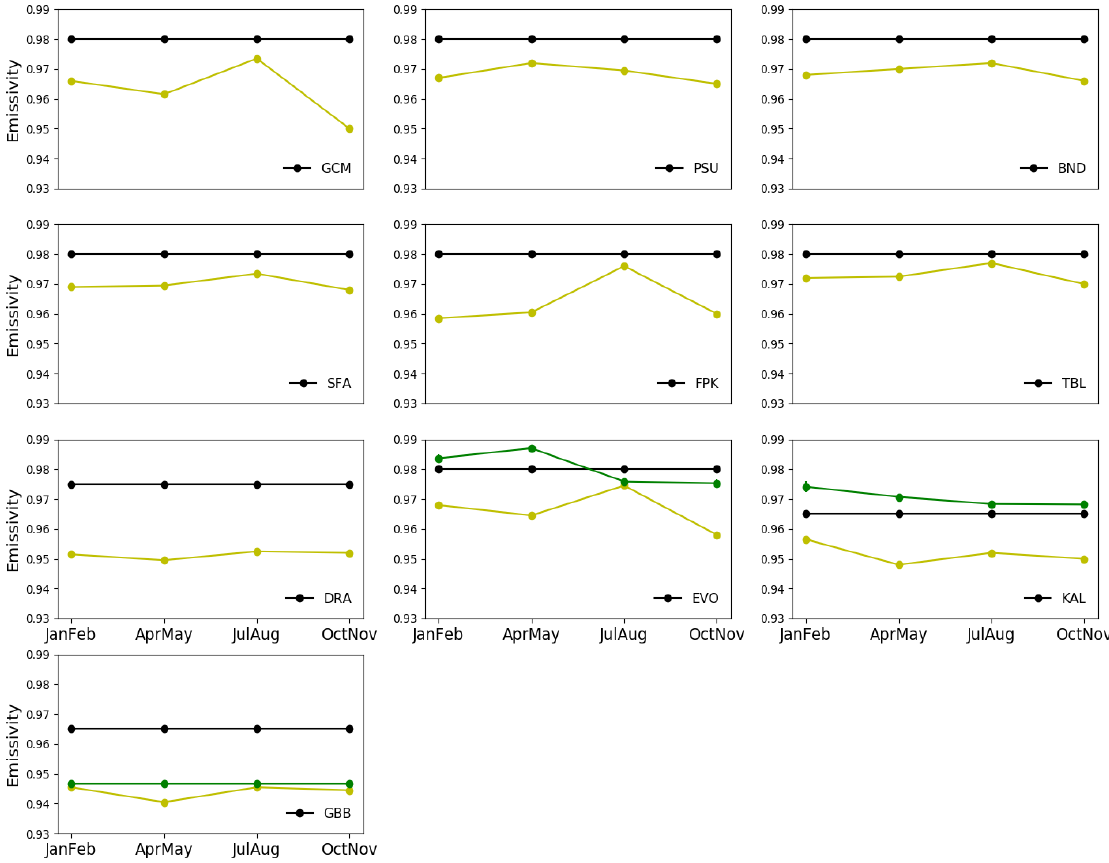
Figure 6. Emissivities used at the ground station location in the LST retrieval from ISCCP and SEVIRI (when available), and from the estimates of CIMSS. Black: ISCCP. Green: SEVIRI. Yellow: